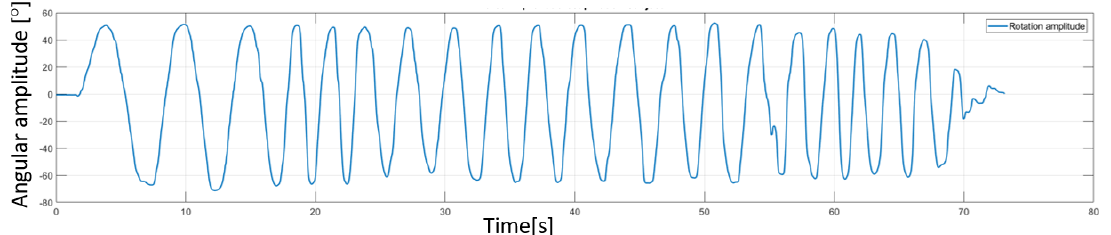
Figure 14. Amplitudes recorded using Biometrics sensor system for a pronation/supination rehabilitation session.